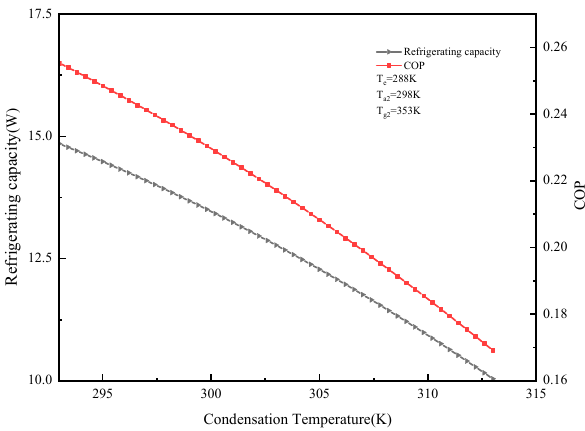
Figure 7. Effect of condensation temperature on refrigeration capacity and COP.